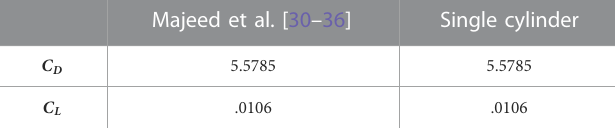
TABLE 1 Code validation test compared to Majeed et al. [30 –